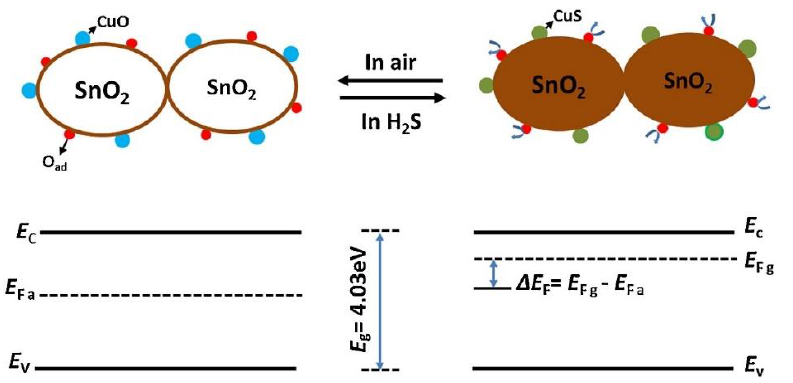
Figure 13. Flat band energy level of the CuO-decorated SnO 2 QDs in air ( left ) and H 2 S atmosphere ( right ) [114].